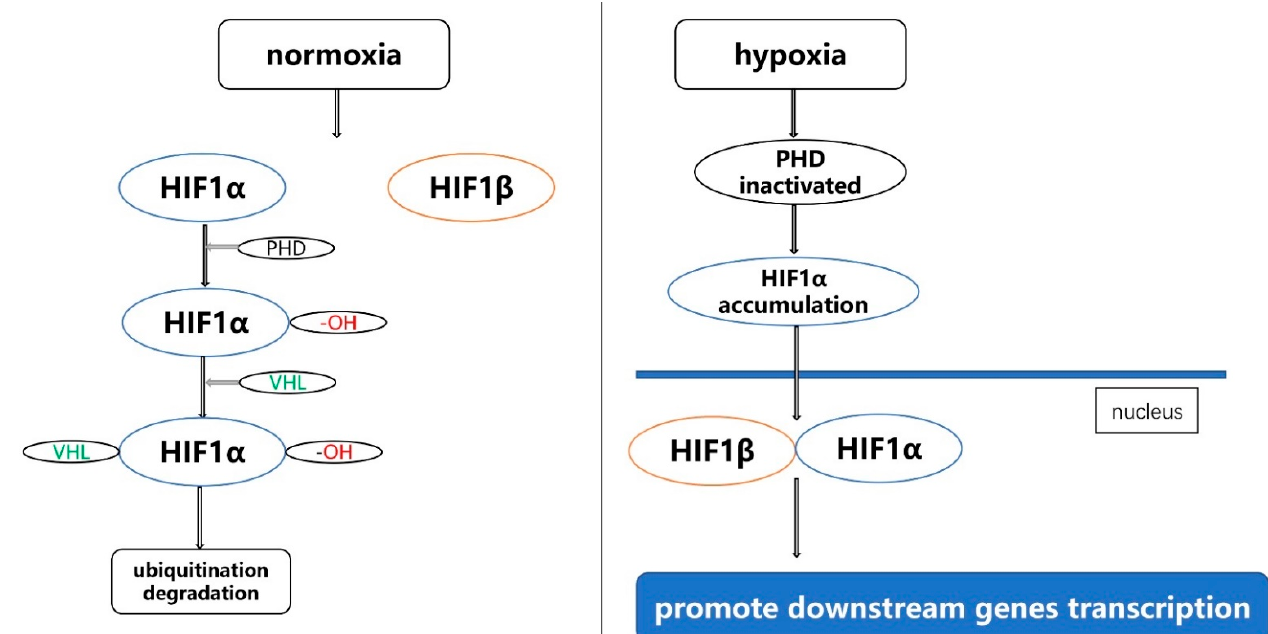
Figure 1. The mechanism of function of HIF1 under normoxia and hypoxia.